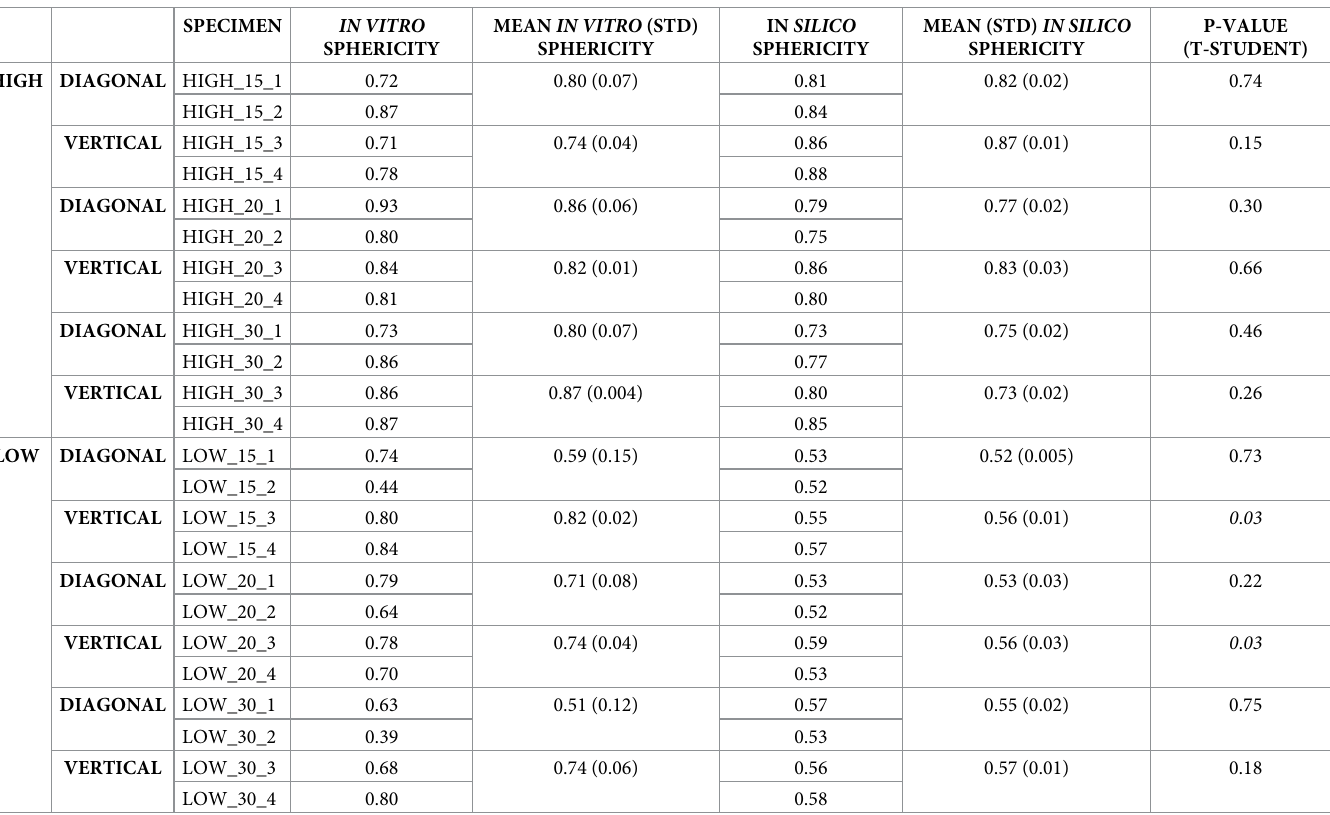
Table 3. Sphericity of the cement cloud in all cases tested in vitro and in silico. STD indicates standard deviation.